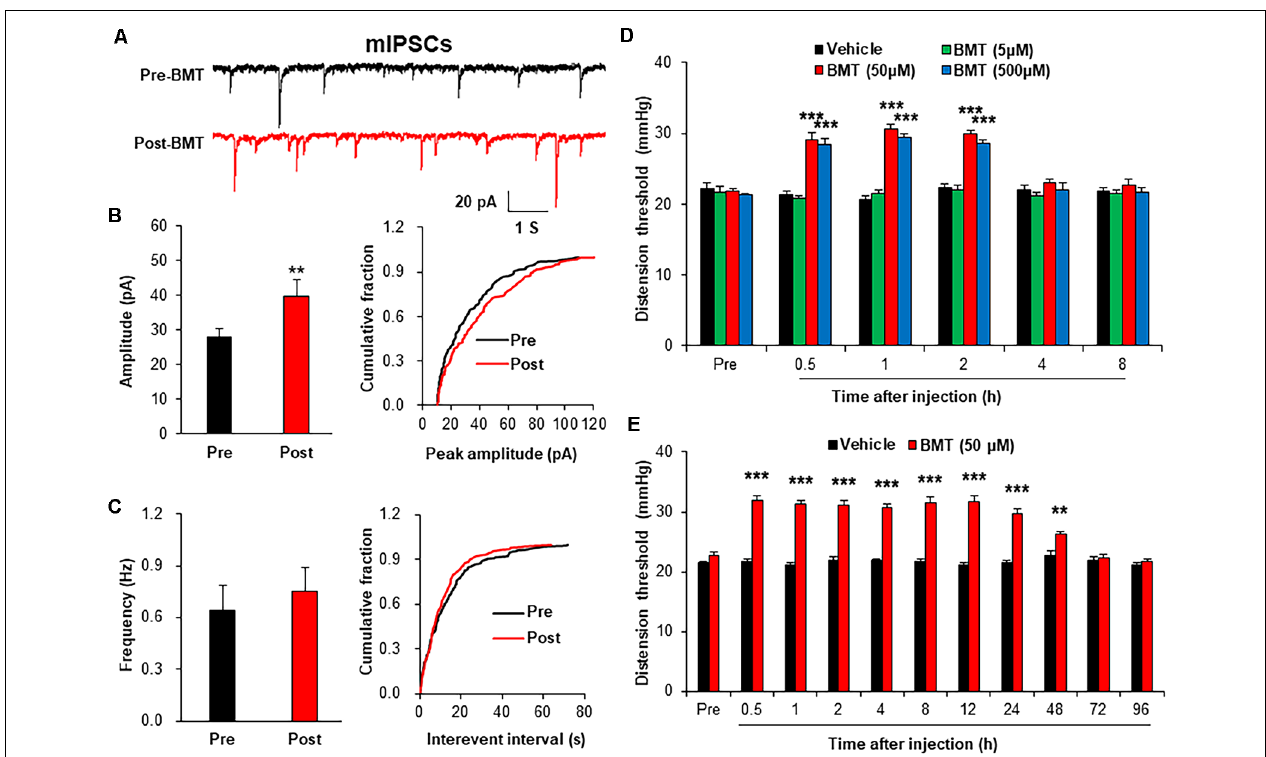
FIGURE 6 | Bumetanide (BMT) enhanced spinal mIPSCs and visceral pain threshold in NMD rats. (A) Representative traces of mIPSCs were recorded in spinal dorsal horn neurons of NMD rats before and after incubation of BMT. (B) Bar plots and cumulative probability distributions of the amplitude of mIPSCs recorded in spinal dorsal horn neurons of NMD rats before and after incubation of BMT (** P < 0.01, n = 6 cells for each group, two-sample t -test). (C) Bar plots and cumulative probability distributions of the frequency of mIPSCs recorded in spinal dorsal horn neurons of NMD rats before and after incubation of BMT ( P > 0.05, n = 6 cells for each group, two-sample t -test). (D) Behavioral changes of NMD rats after intrathecal injection of BMT at different doses (5, 50, and 500 µ M, *** P < 0.001, n = 6 rats for each group, Tukey post hoc test following two-way repeated-measures ANOVA). (E) Behavioral changes of NMD rats after intrathecal injection of BMT (50 µ M) for seven consecutive days (** P < 0.01, *** P < 0.001, n = 6 rats for each group, Tukey post hoc test following two-way repeated-measures